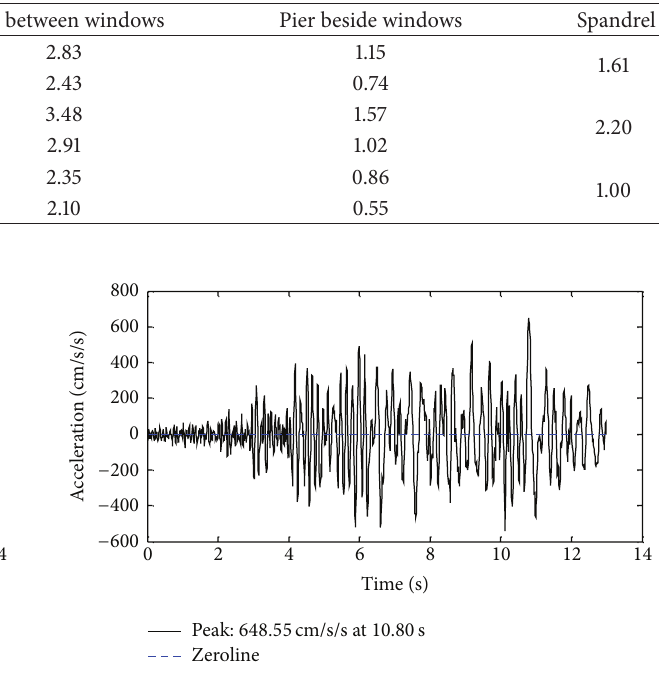
Figure 11: The time history curve of Wolong ground motion in 𝑌 direction.